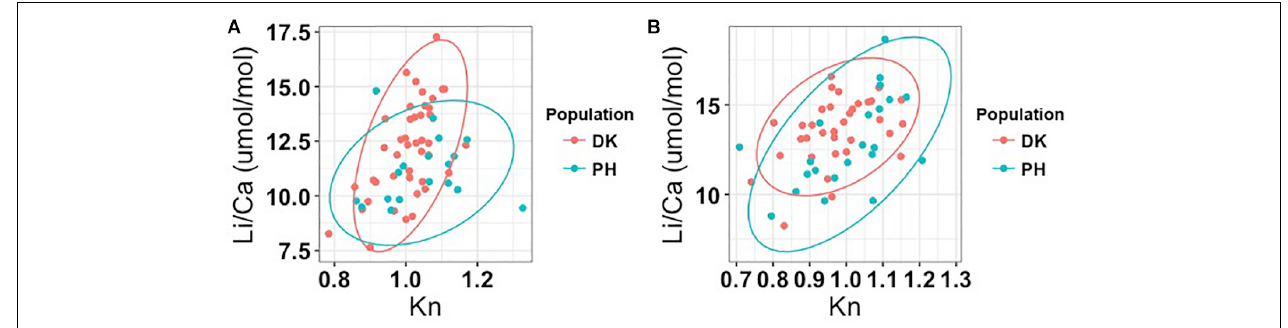
FIGURE 4 | Relationship between temperature-corrected Li/Ca and Kn (relative growth condition) values between two study populations. Only individuals at stage 3a were used in the analysis. Comparisons are given for females (A) and males (B) . Results of multiple linear regression are presented in Table 5 .